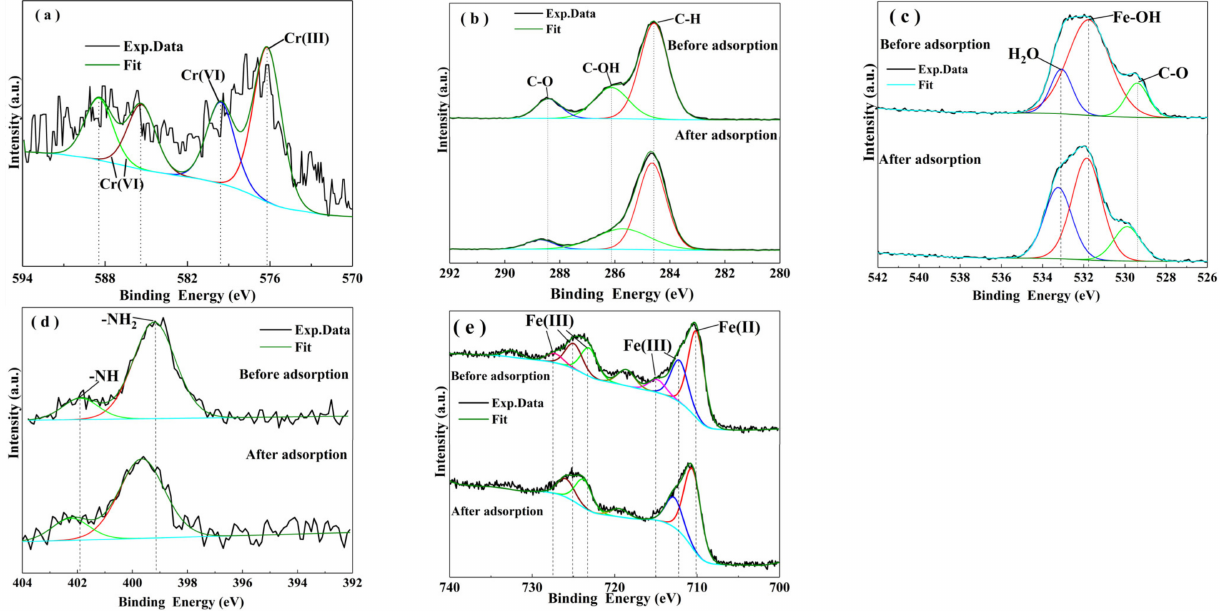
Figure 4. The XPS response spectra of Cr2p ( a ) after Cr(VI) adsorption, and C1s ( b ), O1s ( c ), N1s ( d ), and Fe2p ( e ) before and after Cr(VI)